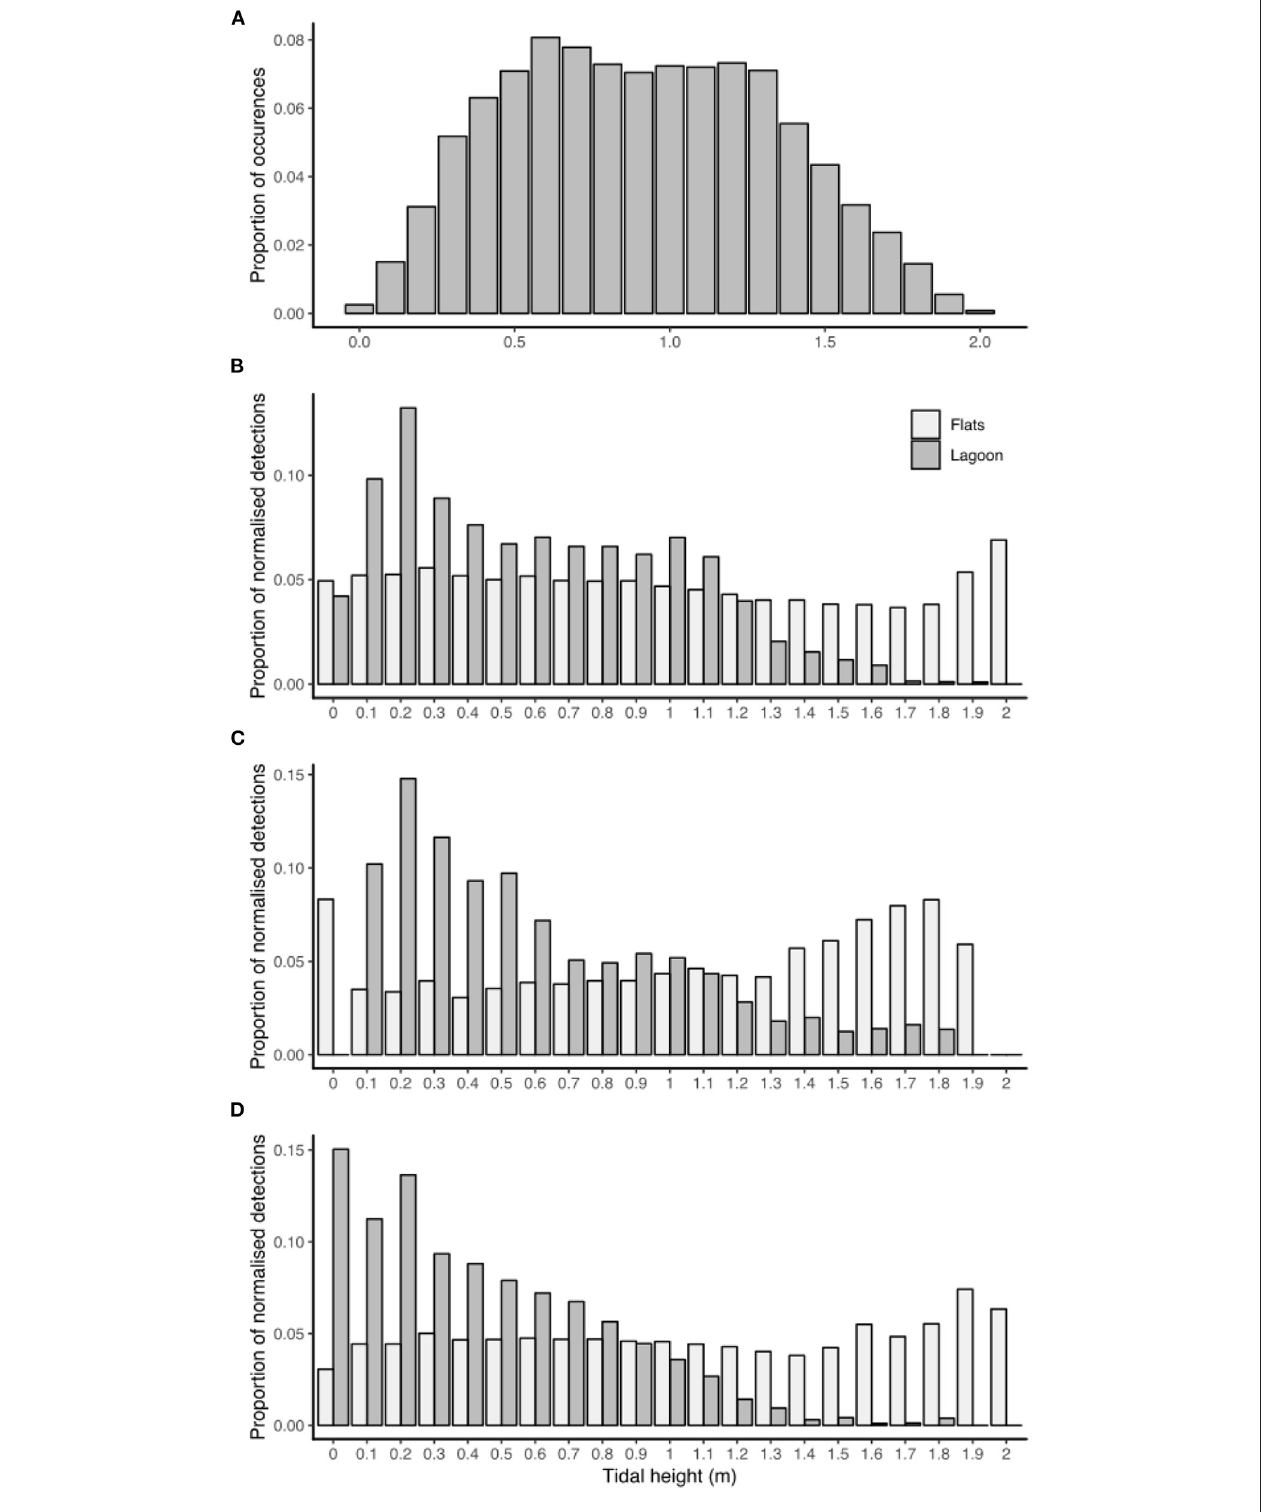
FIGURE 4 | Histogram of tidal height bin occurrences for June 2015–May 2016 in St. Joseph Atoll (A) . The proportions of acoustic detections (normalized with the proportion of occurrences each tidal height bin) in each tidal height bin for each habitat type (reef flats or lagoon) recorded by P. ater (B) , U. asperrimus (C) , and U. granulatus (D)